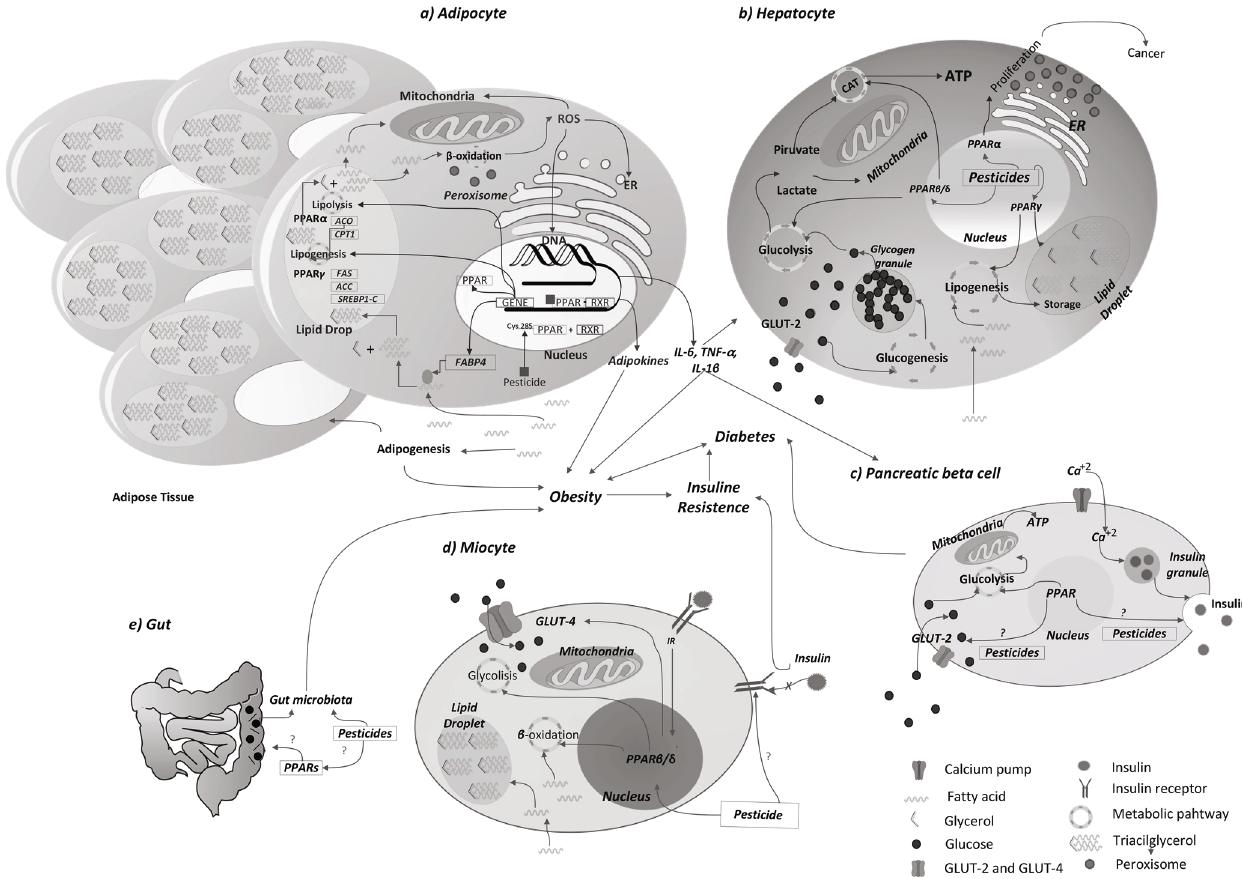
Figure 2: E ff ects of pesticides on carbohydrate and fat metabolism involving diabetes and obesity through activation of PPARs. Activation of PPARs by pesticides and their e ff ects have been linked to the development of obesity and diabetes in many tissues: adipocytes (a) show mainly PPAR α and PPAR γ activation to lipid metabolism; in hepatocytes (b) PPAR γ is involved in lipid metabolism, PPAR α is associated with peroxisome proliferation to cancer and PPAR β / δ in the carbohydrate metabolism; in pancreatic beta cells (c) the role of PPAR a ff ected by pesticides and the function of these cells is not clear; in myocytes (d) PPAR β / δ activation is essential for the regulation of energy metabolism, but the e ff ects of pesticide exposure are unclear; fi nally, (e) the disruption of the gut microbiota in the development of obesity and diabetes about PPAR activation is unknown. Abbreviations: ACC, acetyl Co-A carboxylase; ACO, acyl-CoA oxidase; AMPKa, AMP-activated protein kinase alpha; ATP, adenosine triphosphate; C/EBP- α , CCAAT enhancer binding protein alpha; C/EBP- δ , CCAAT enhancer binding protein delta; C/EBP- β , CCAAT enhancer binding protein beta; CPT-1, carnitine palmitoyltransferase I; ER, endoplasmic reticulum, FABP4, fatty acid-binding protein 4; FAS, fatty acid synthase; GLUT-2, glucose transporter type 2; GLUT-4, glucose transporter type 4; LPL, lipoprotein lipase; PPAR α , peroxisome proliferator-activated receptor alpha; PPAR β / δ , peroxisome proliferator-activated receptor beta/delta; PPAR γ , peroxisome proliferator-activated receptor gamma; ROS, reactive oxygen species; RXR, retinoid X receptor; SREBP-1C, sterol regulatory element-binding protein 1, TG,